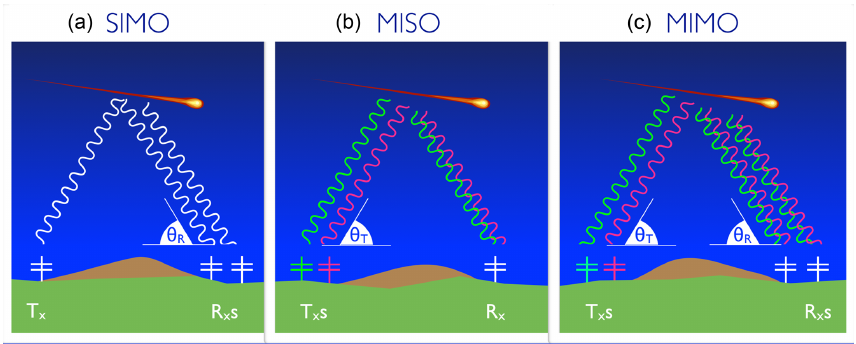
Figure 1. A sketch representing three types of SMR systems: (a) the classic system of using a single transmitter and interferometer on reception (R x s) (SIMO), (b) a proposed system using multiple transmitter (T x s) in interferometer mode at transmission and a single receiver (MISO), and (c) similar to (b) but with interferometry on reception (MIMO). In the case of MISO and MIMO, the transmitter waves forms are indicated with different colors, representing different diversity (different codes in our case). Note that elevation angles are measured with respect to the transmitter ( θ T , AOD) and/or receiver ( θ R ,